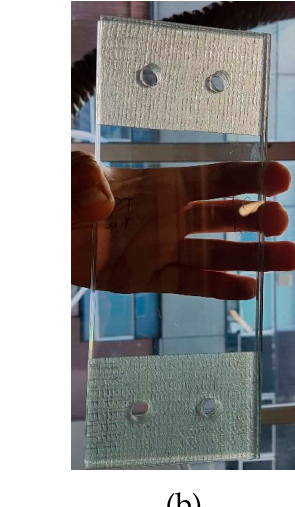
Figure 13. Examples of ( a ) GFRP strips (detail view) for ( b ) GFRP-reinforced bolted connections in structural glass members (reproduced from [84]).